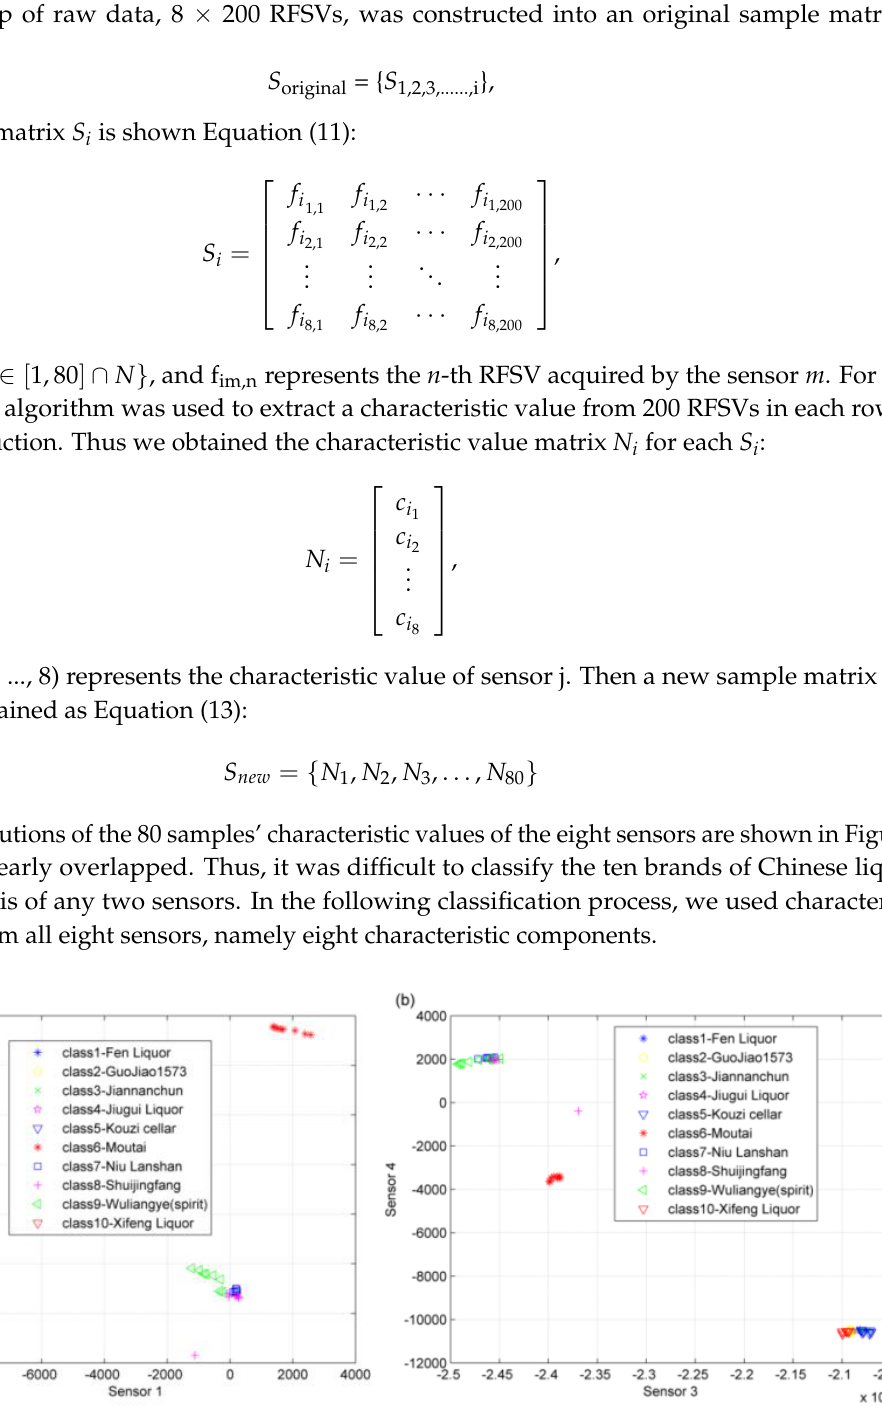
Figure 9 . Cont . Figure 9.